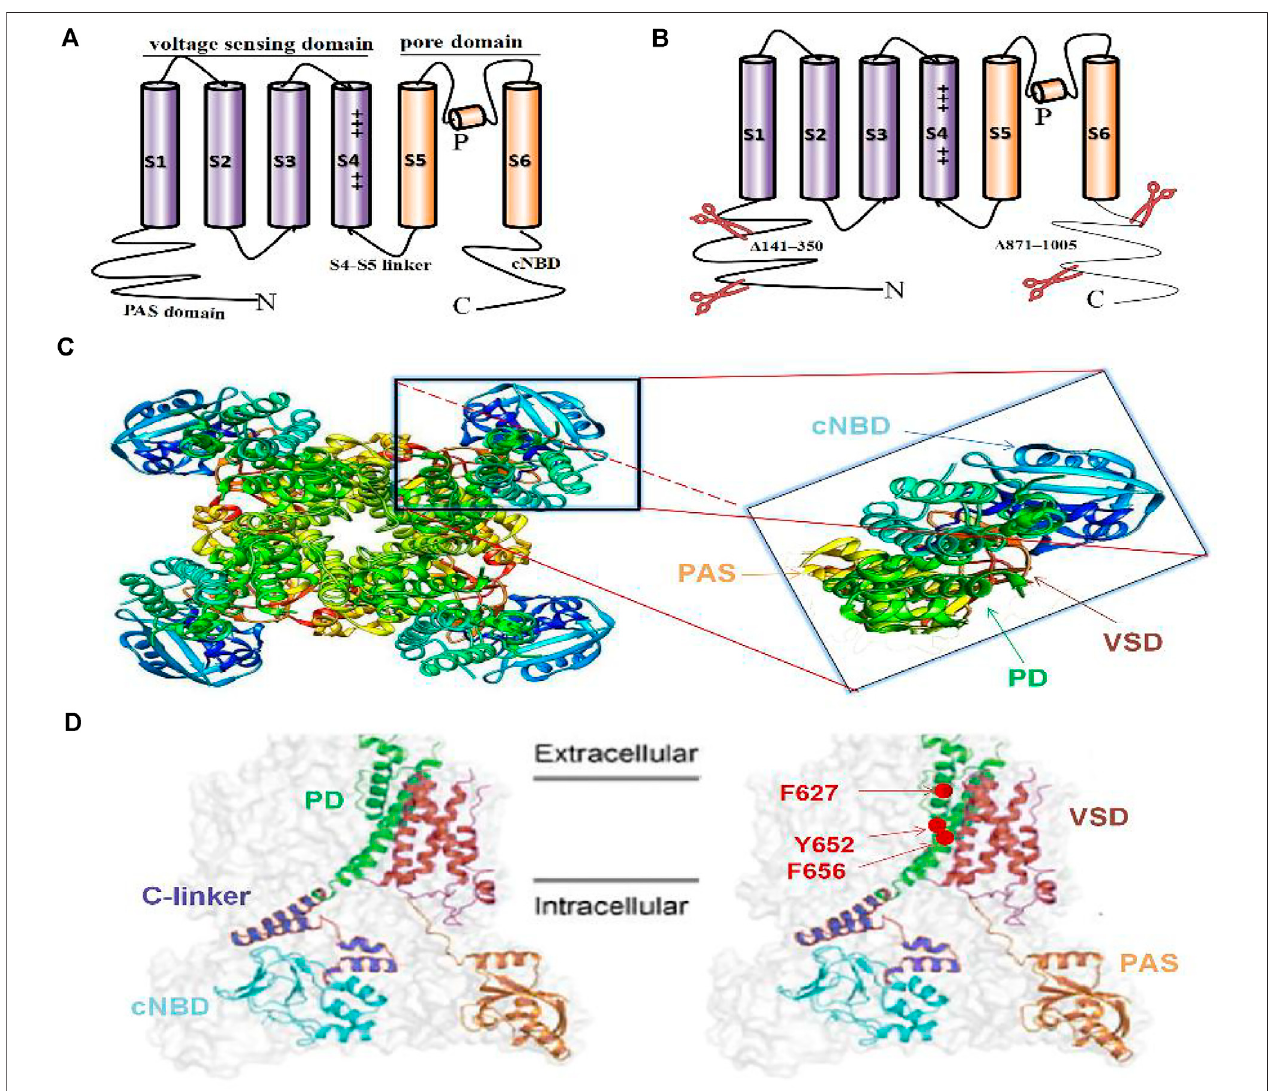
FIGURE 2 | Single alpha subunit of the previous hERG structure (A) , new hERG T structure (B) , 3D side view of full hERG T (C) , obtained from PDB: 5VA2; hERG T ) andsinglesubunitofthehERG T onthecellmembrane (D) .TheclassicVGKchannelstructure containssixtransmembranesegmentsS1-S6,S1-S4containschargesto formthevoltage-sensingdomain(VSD),andS5-S6formstheporedomain(PD) (A) .Cryo-electronmicroscope(cryo-EM)structurehERG T withdeletionoftheN-terminal 141 – 350 and the C-terminal 871 – 1,005 of the non-structural sequence to prevent aggregation during puri fi cation (B) . Full-length hERG T channel contains four subunits arranged in a circular pattern around a central PD (C-left) and magnifying single subunit, colored to distinguish different domains (C-right). The color-marked single subunit corresponding to the above 3D structure on the cell membrane, including the PAS domain at the N-terminal and the C-terminal cyclic nucleotide binding domain (cNBD), transmembrane PD and VSD, as well as the main blocking sites Y652, F656 for speci fi c cardiotoxicity drugs and F627 involving inactivation (D) .